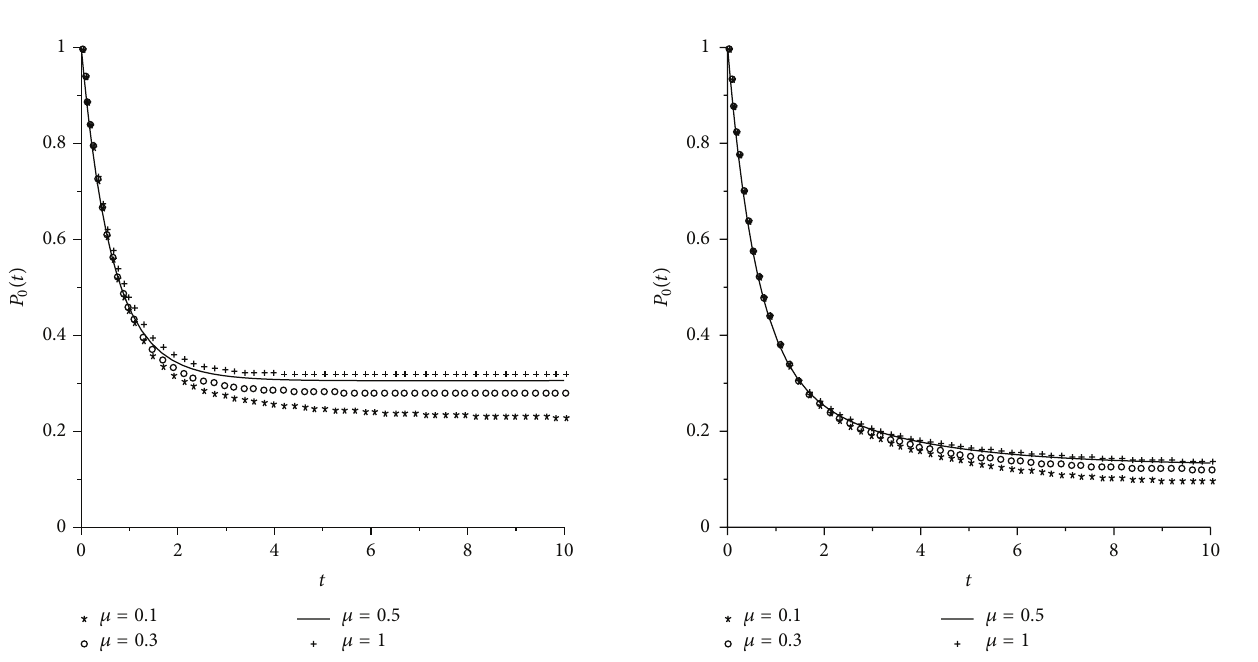
Figure 4: Instantaneous probabilities of the system with warning device in good state with different 𝜇